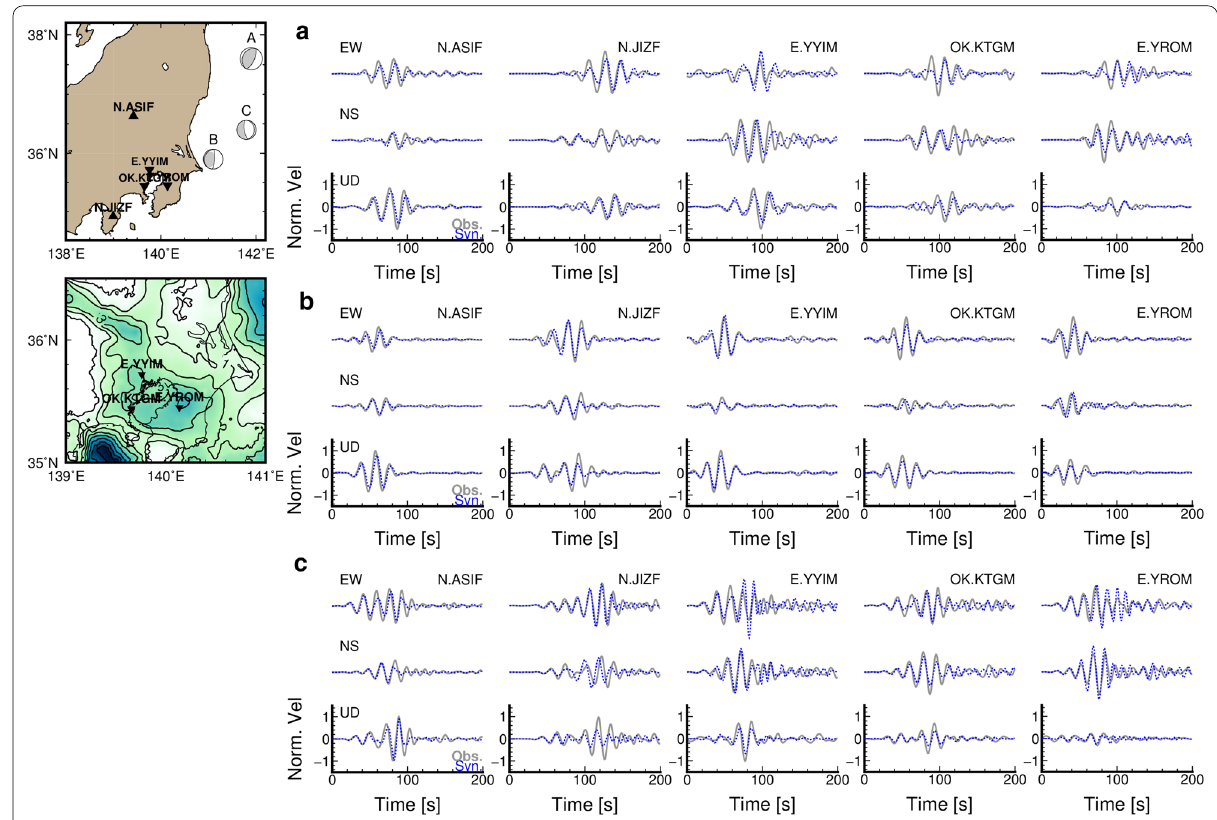
Fig. 10 Comparisons between observed and simulated seismograms for periods of 15–30 s. We selected two F-net (N.ASIF and N.JIZF) and three MeSO-net (E.YYIM, OK.KTGM, and E.YROM) stations. Amplitudes at each station were normalized by the maximum amplitudes of observed seismograms for periods of 15–30 s at each station. a Event A, b Event B, and c Event C. Gray and blue dotted lines are the observed and simulated seismograms, respectively. Left panels show used stations and bedrock depths of the JIVSM. Color for bedrock depths is similar as Fig.